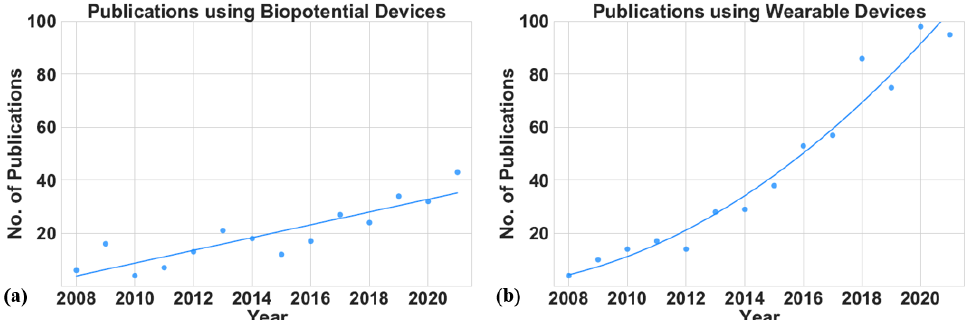
Figure 11. The number of research publications between 2008 and 2021. ( a ) Studies that use biopoten- tial devices for PD assessment, ( b ) studies that use wearable devices for PD assessment. The solid lines shows the trend of the publications in the last 14